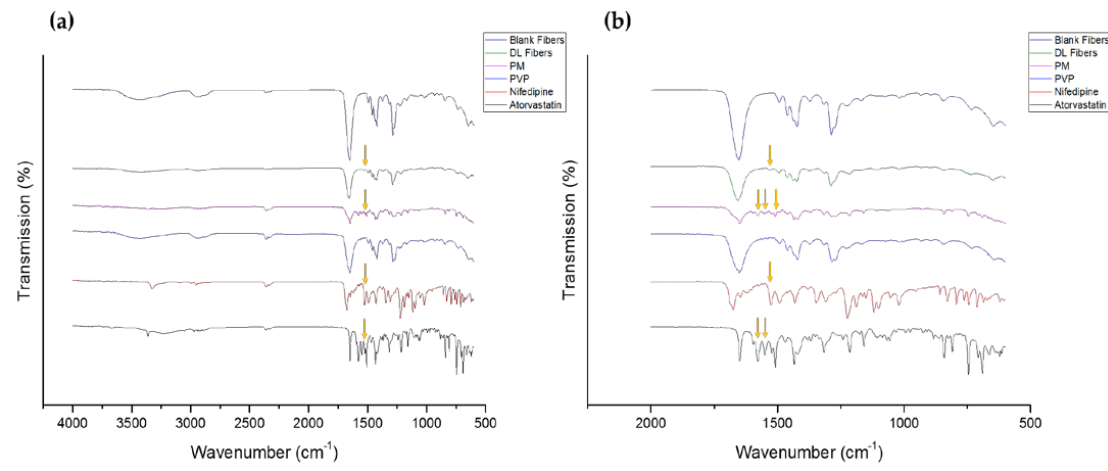
Figure 4. FTIR transmissions at ( a ) a full wavenumber range (4000 to 600 cm − 1 ), and ( b ) more focused range (2000 to 600 cm − 1 ) of PVP, nifedipine, atorvastatin calcium, PM, blank and drug-loaded nanofibers showed the distinctive drugs’ peaks at 1493 cm − 1 and 1509 cm − 1 that appeared in the PM and drug-loaded nanofibers but not in the blank nanofibers.